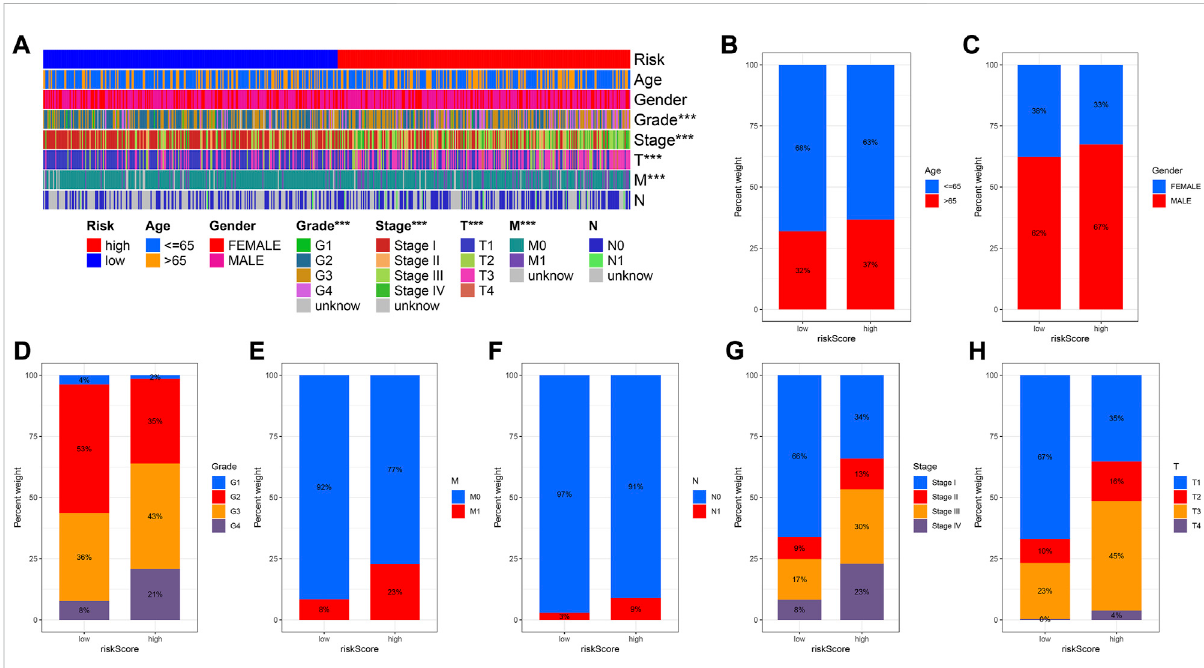
FIGURE 6 Correlation between risk score and clinicopathological factors. (A) Heatmap for CRlncRNAs prognostic signature and clinicopathological factors. (B – H) Proportion and distribution of patients with different clinical traits in high- and low-risk